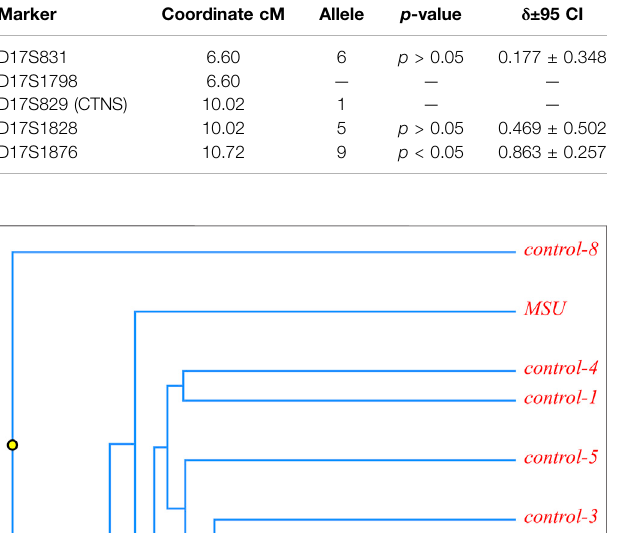
TABLE 6 | Linkage disequilibrium analysis between CTNS c.518A > G mutation and microsatellites closest to the CTNS mgene. Marker Coordinate cM